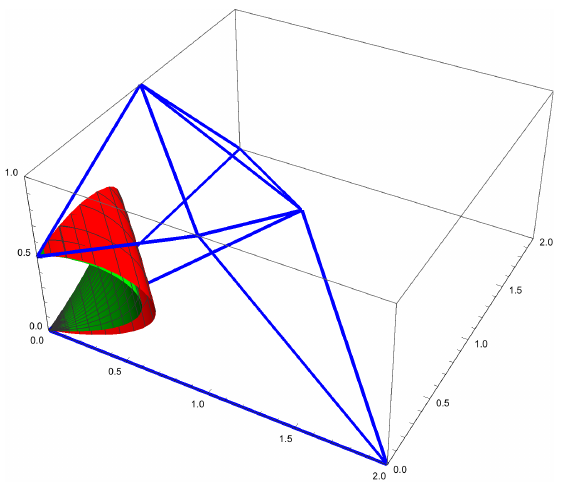
Figure 4: The actual control mesh of truncated triangular Meyer-König-Zeller surfaces with m = 2, n = 1 (the green one) and m = 2, n = 3 (the red one).